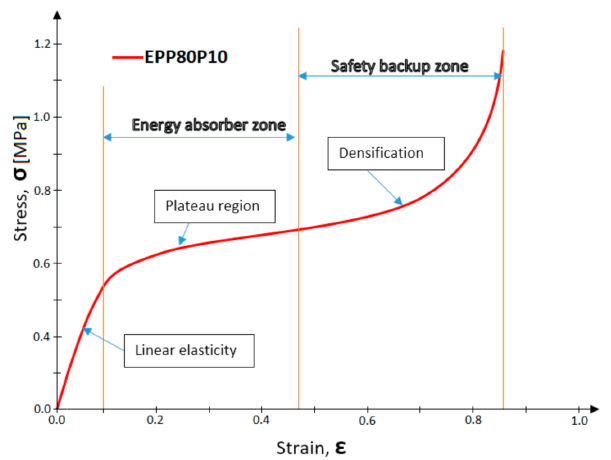
Figure 4. Regions of EPP static stress-strain